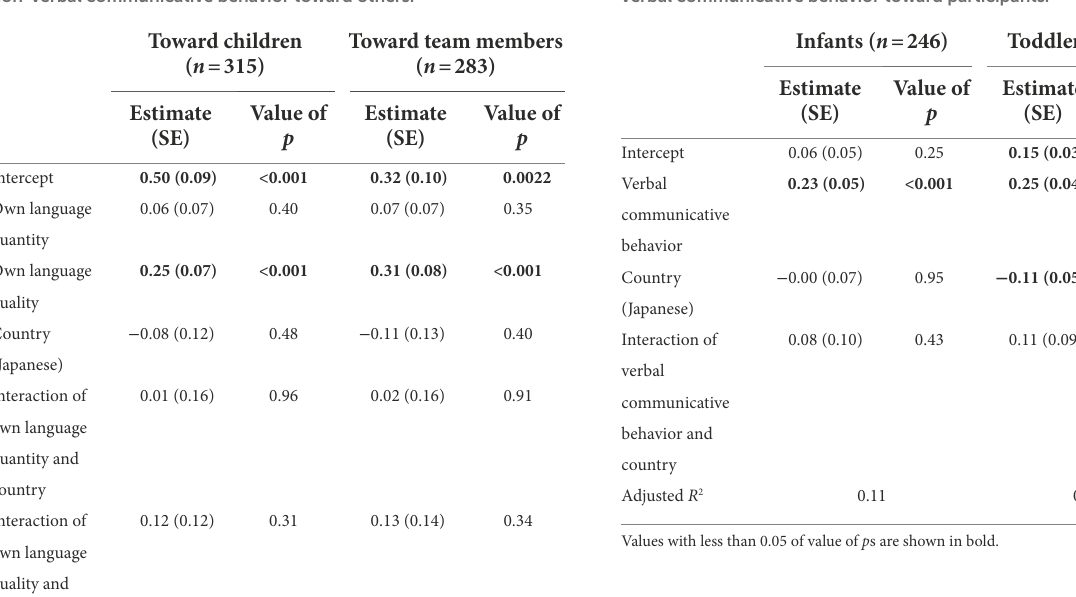
TABLE 6 The linear regression models predicting educators’ own non-verbal communicative behavior toward others.